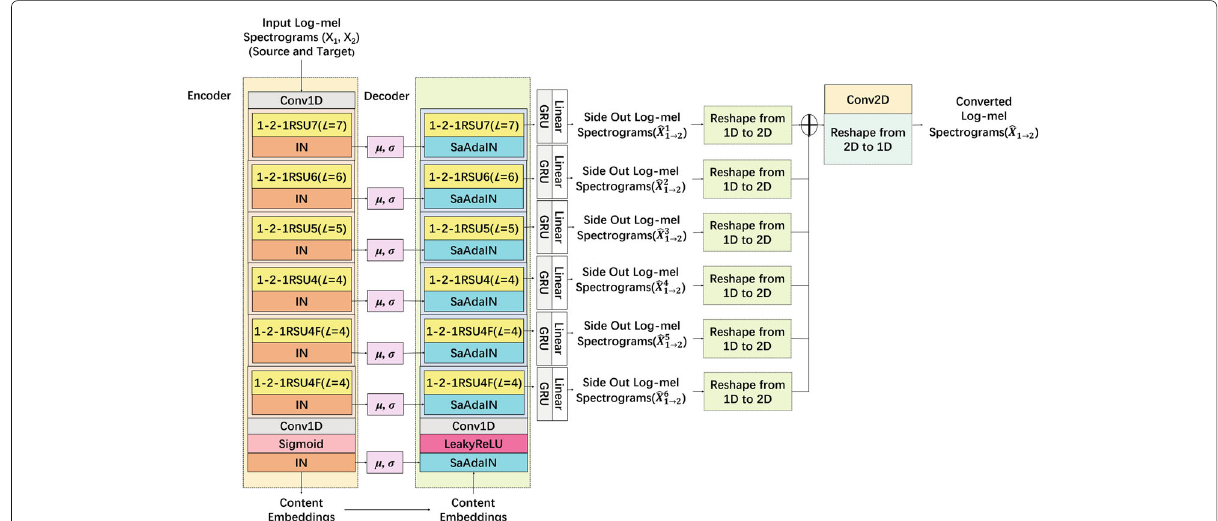
Fig.1 The architecture of U 2 -VC. The 1-2-1 residual U-blocks (RSU) with different layers (1-2-1RSU7, ··· ,1-2-1RSU4F) consist of the U-Net like encoder- decoderstructure.“7”,“6”,“5,”and“4”representthelayers( L )of1-2-1residualU-blocks.GreaterLmeansthe1-2-1residualU-blockcouldcapturemore large-scale information . In this network, we set the L from large to small in order to extract the features from the global to the detail. This process preserves more fine details of input features which could be better for the naturalness of converted speech. Inspired by AGAIN-VC, sigmoid function is used at the end of encoder. Sandwich adaptive instance normalization (SaAdaIN) is adopted in decoder for speaker identity